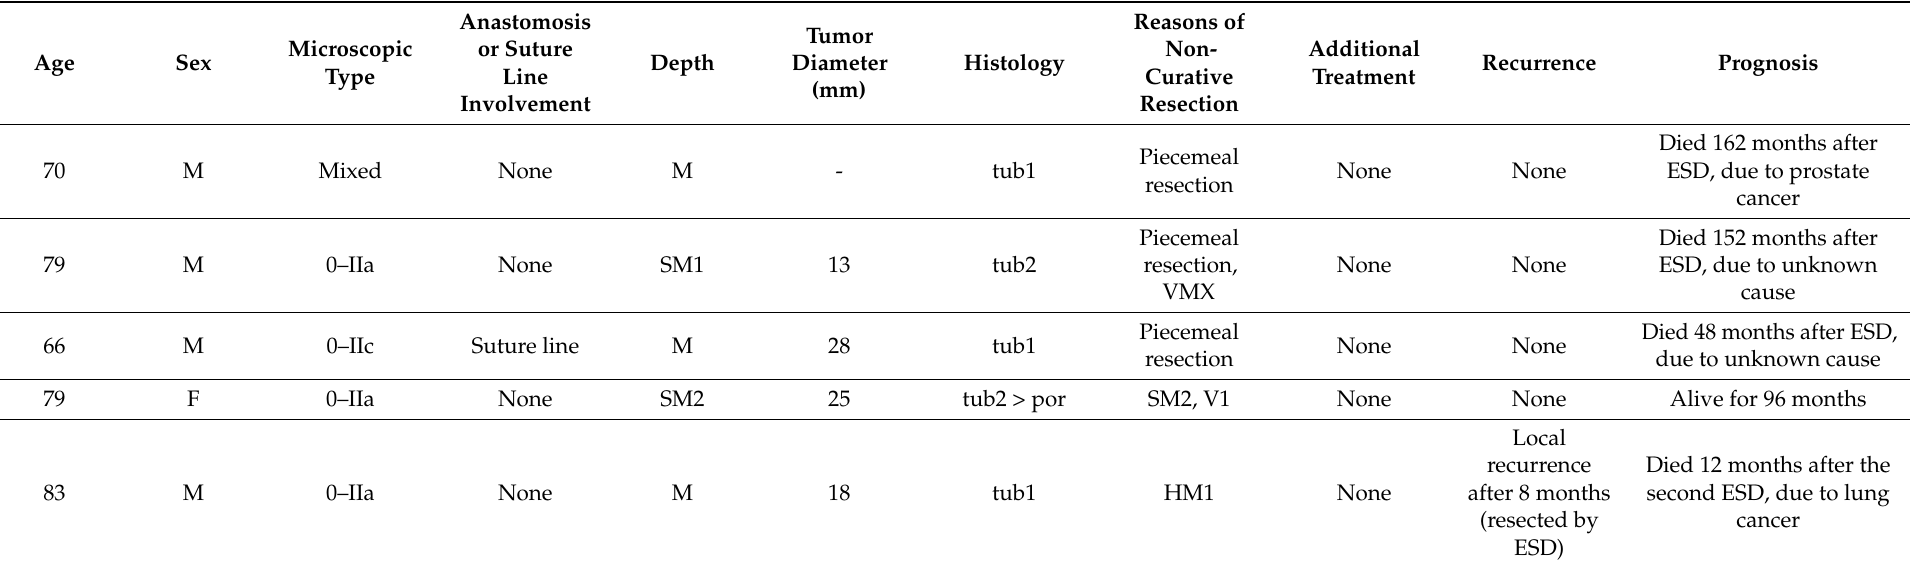
Table 5. Characteristics of non-curative resection